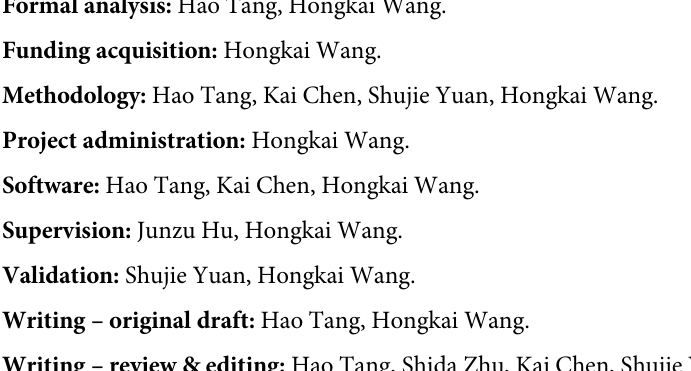
S1 Fig. Effect of 3-MA on cell viability. S1 Table. Sequences of primers used in RT-PCR analysis.